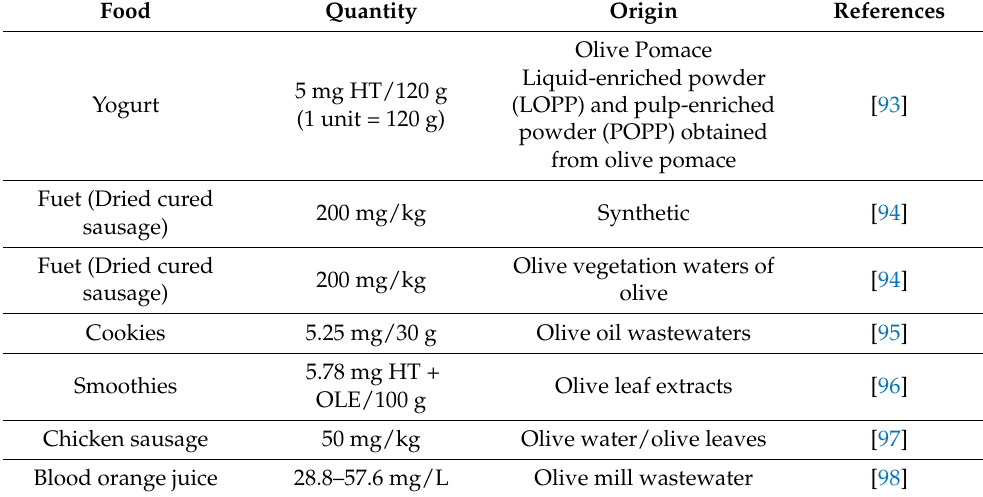
Table 7. Food ingredients and future